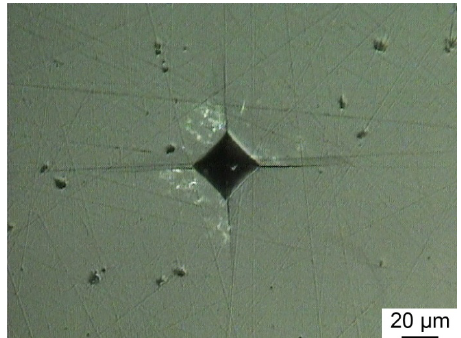
Fig. 11 Indentation on the surface of 8YSZ transparent ceramics pre-sintered at 1280 ℃ for 4 h and HIP post- treated at 1350 ℃ for 3